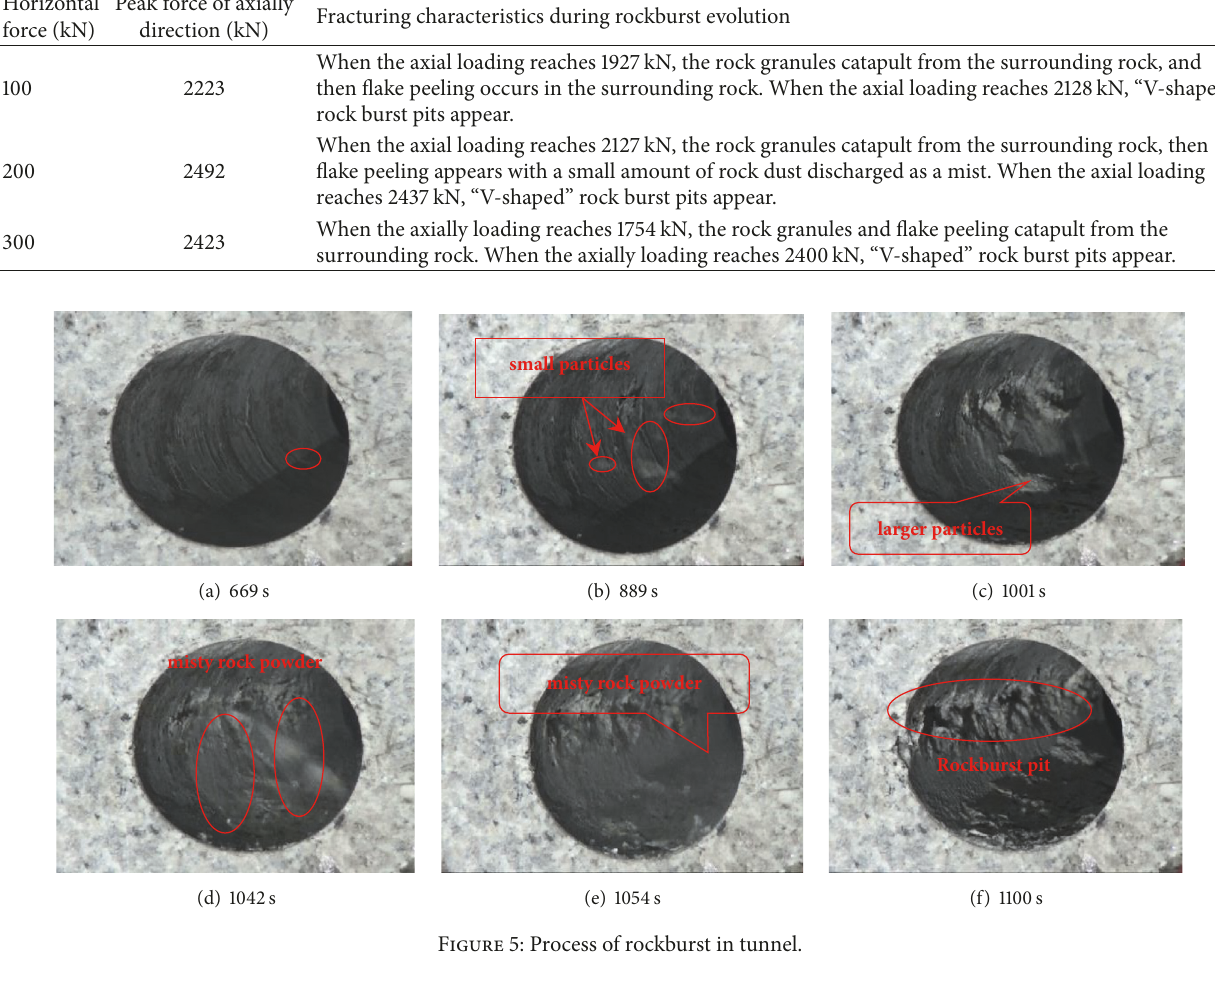
Figure 5: Process of rockburst in tunnel.